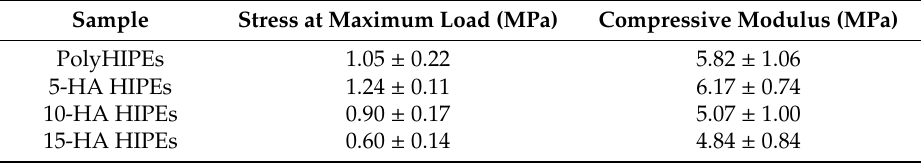
Table 2. Mechanical properties of poly(TT / DPEHA / HA)HIPEs under compression.